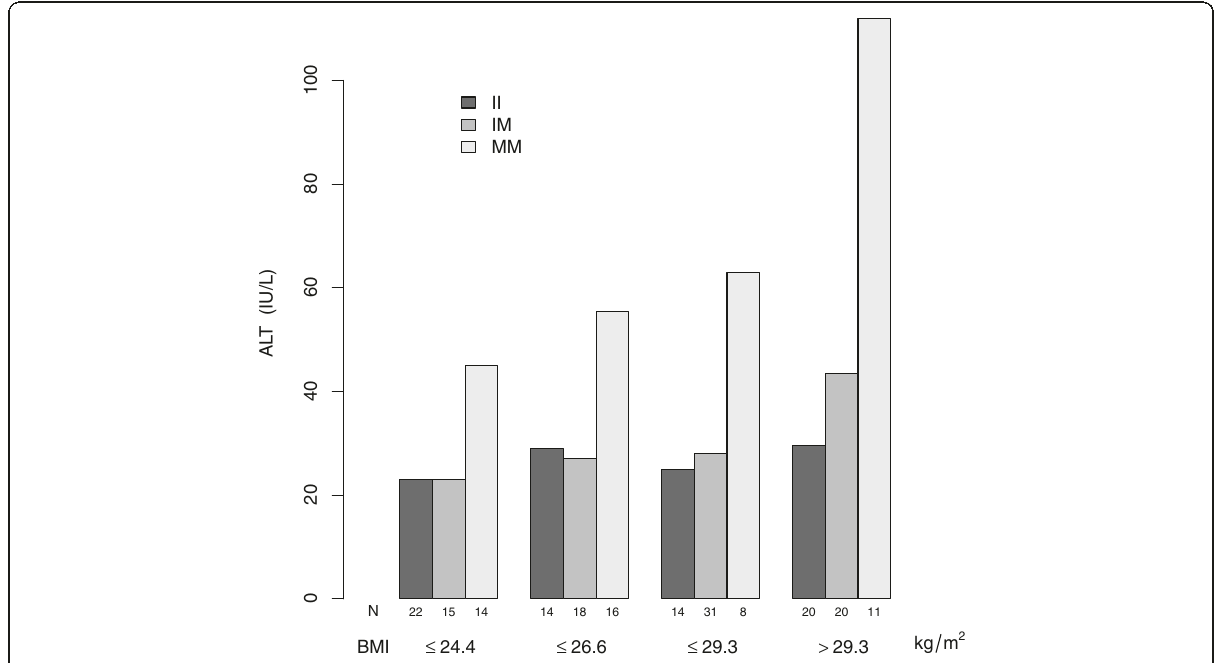
Figure 1 Interaction between PNPLA3 I148M and BMI towards elevated ALT levels in NAFLD cases. Cases were first stratified into quarters by BMI; in each quarter cases were further stratified by the I148M genotype, and in each group the median of ALT levels was